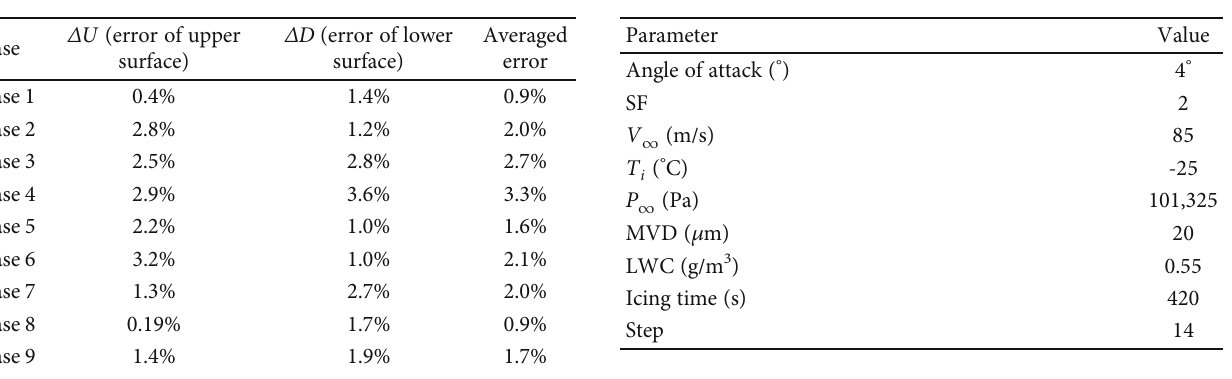
Figure 13: Comparison of Cp test for (a) Case 1 — Hy00, (b) Case 2 — Hy02, (c) Case 3 — Hy04, (d) Case 4 — Hy06, (e) Case 5 — Hy08, (f) Case 6 — Hy010, (g) Case 1 — Hy20, (h) Case 2 — Hy22, (i) Case 3 — Hy24, and (j) Case 4 — Hy26. Table 3: Upper and lower surface ’ s error for di ff erent cases. Table 4: Simulation